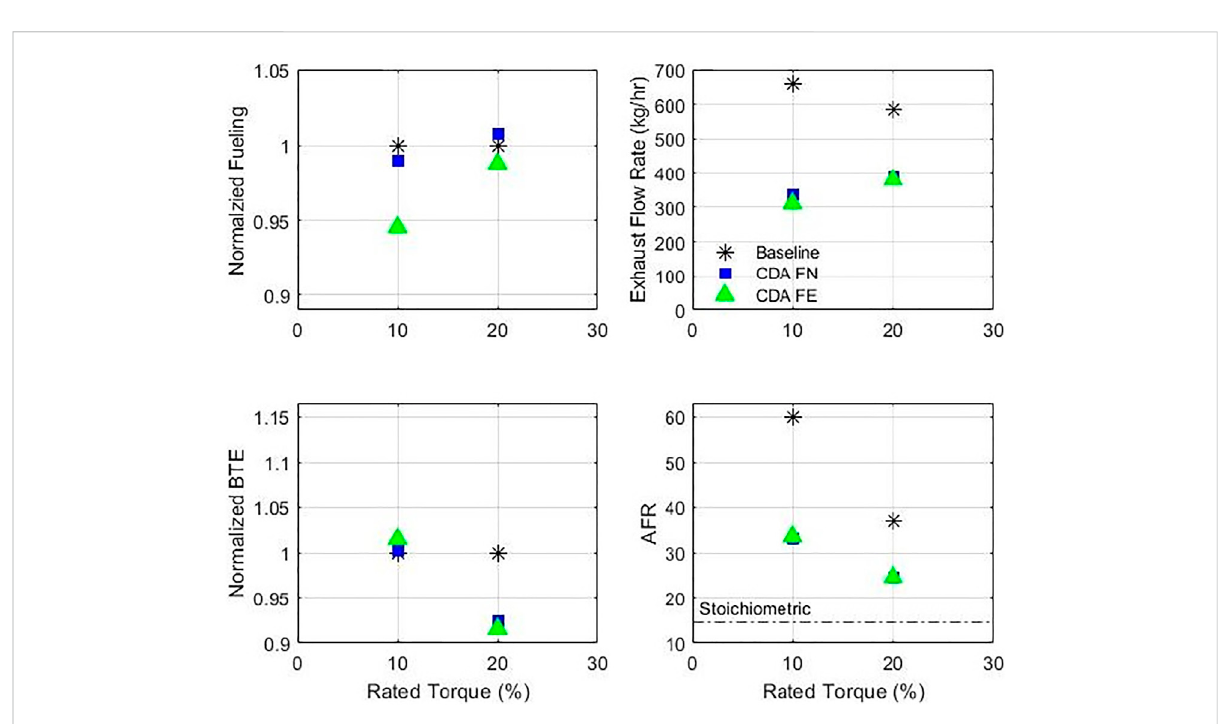
FIGURE 8 1200 rpm steady state engine